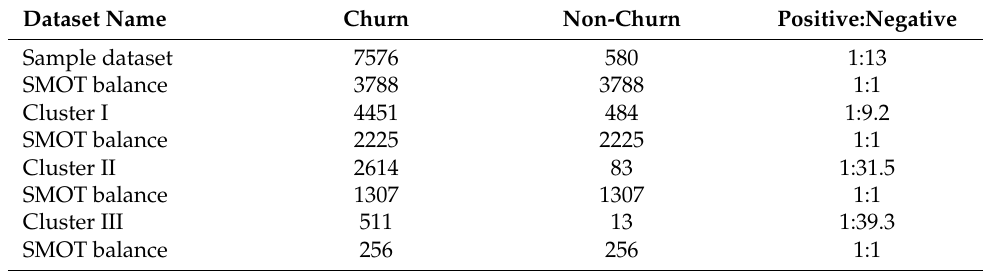
Table 4. The balanced